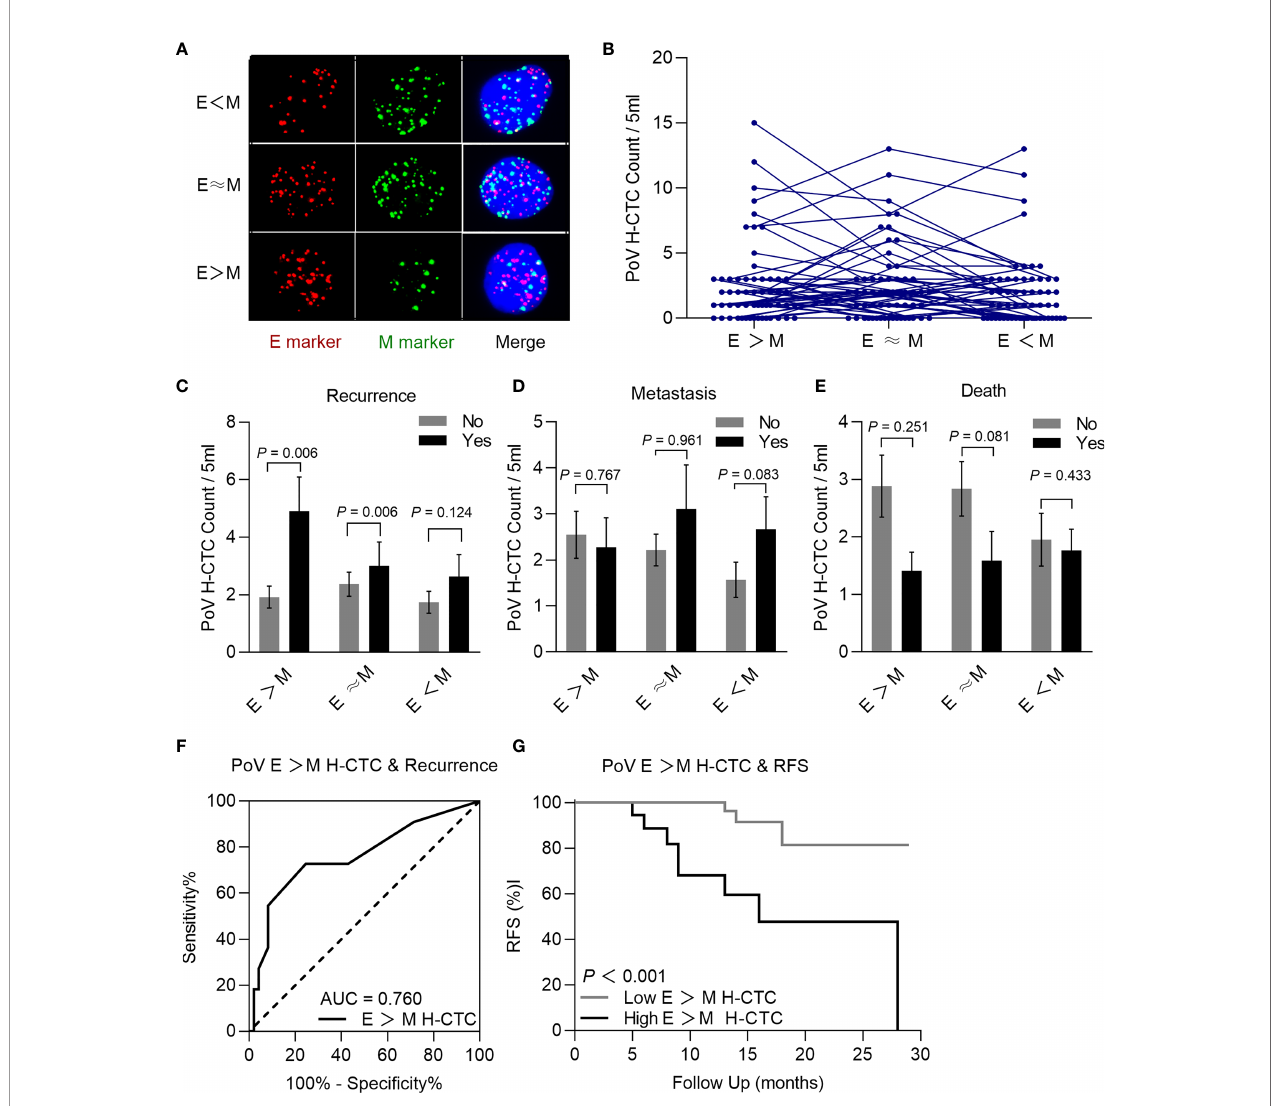
FIGURE 6 | Typical multi- fl uorescence signals of hybrid CTCs subtypes andcorrelation with prognosis. (A) Epithelial predominant (E> M) hybrid CTC, intermediate(E ≈ M) hybrid CTC, ormesenchymalpredominant (E<M)hybrid CTC. (B) Each H-CTC subtype count inpatients (n=60).Comparison of PoV H-CTC subtype counts with prognosis, recurrence (C) , metastasis (D) , and death (E) , the result demonstratedthat recurrence patients hadsigni fi cantlyhigher E > M H-CTC counts than recurrence-freepatients ( P <0.05). (F) ROC curvewas used to determine that the cut-off value of E > M H-CTC countwas 3/5 ml(AUC = 0.760, sensitivity = 72.7%,speci fi city =75.5%, P =0.004). (G) Kaplan – Meier analysis showed that patients with E>MH-CTC ≥ 3/5ml had signi fi cantly shorter RFS than patients with E>M H-CTC<3/5ml ( P <